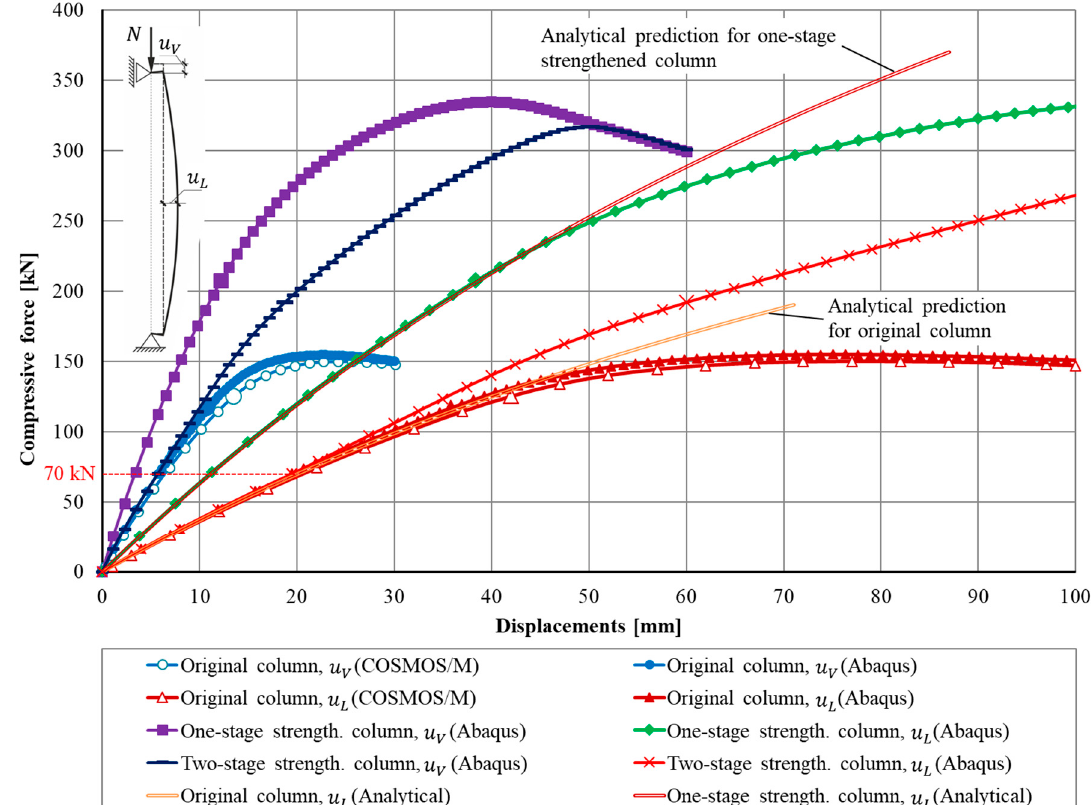
Figure 8. Load-displacement paths of the column compressed by the force N acting on an eccentricity e.